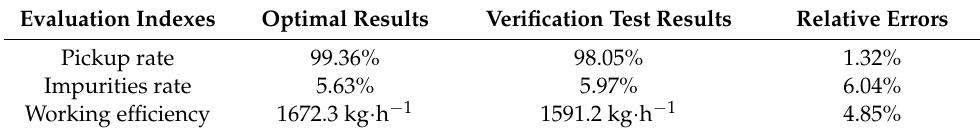
Table 5. Comparison of the optimal results and the verification test results for evaluation indexes. Evaluation